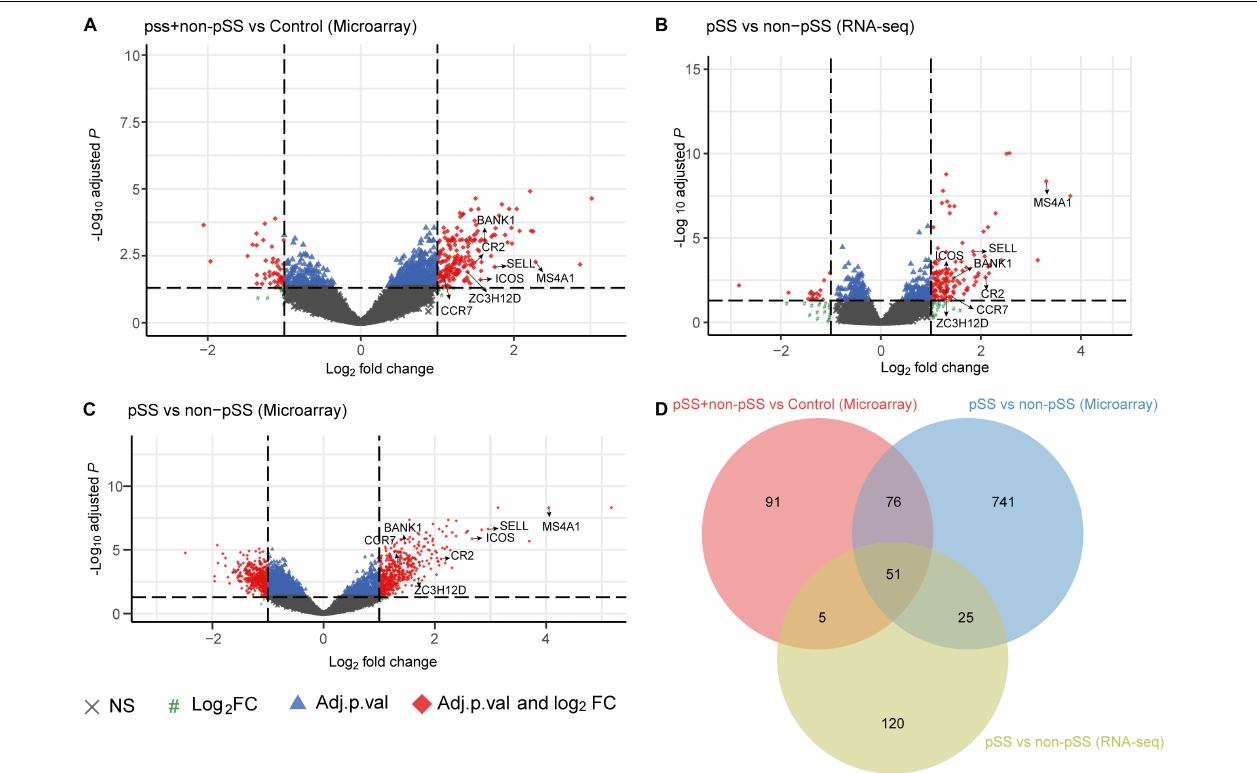
FIGURE 2 | Volcano plot showing all the gene expression changes in primary Sjögren’s syndrome (pSS): (A) Differentially expressed genes (DEGs) of pSS + non-pSS vs. control in microarray data, (B) DEGs of pSS vs. non-pSS in RNA-seq data, (C) DEGs of pSS vs. non-pSS in microarray data, (D) Venn diagram showing the common DEGs of the abovementioned three